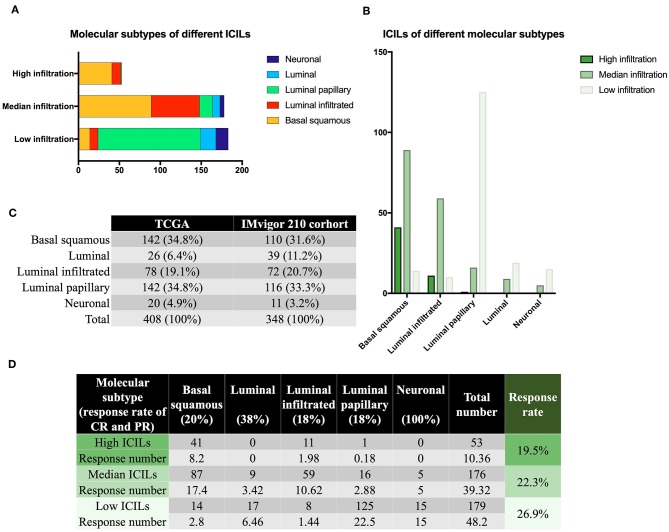
Molecular subtypes and immune infiltration. (A) Different ICILs showed variations in the proportions of molecular subtypes. (B) ICILs of different molecular subtypes were altered. (C) TCGA was similar to the IMvigor 210 trial in terms of total sample size and molecular subtype ratio. (D) The low ICIL group had the highest efficacy after receiving IMCIs. High ICILs had the lowest efficiency. ICILs, immune cell infiltration levels; IMCIs, immune checkpoint inhibitors.